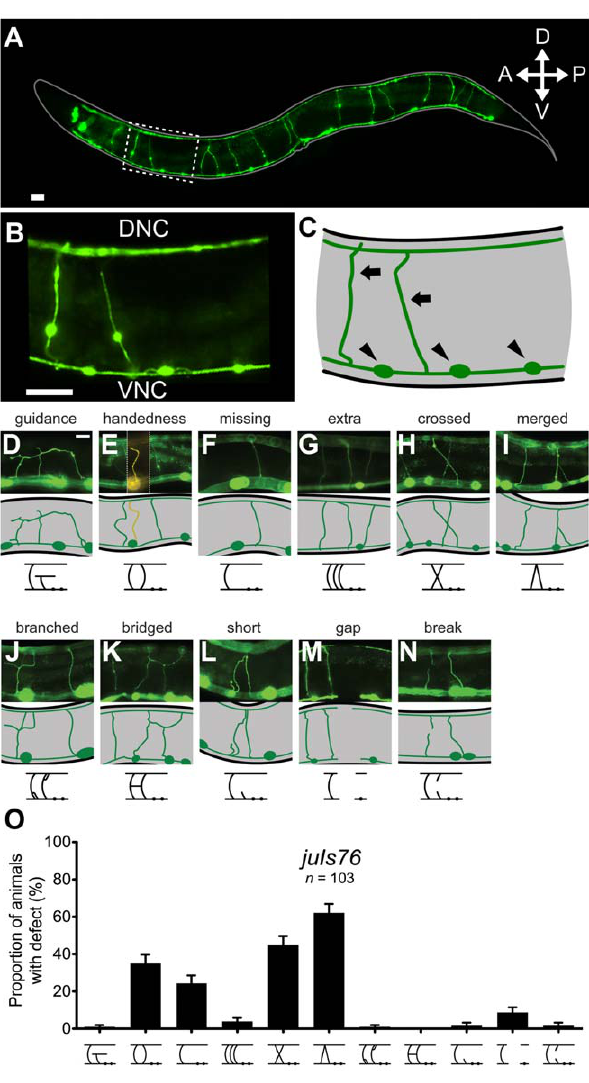
Figure 3. Morphology of wild-type and defective D-type motor neuron commissures. (A) Full body image of adult worm. Scale bar is 25 m m. (B) Expanded view of area within dashed box in panel A. Ventral nerve cord (VNC) is distinguished by presence of neuronal cell bodies. Dorsal nerve cord labeled DNC. Scale bar is 25 m m. (C) Representative image of panel B. Black arrows label neuronal commissures while black arrowheads identify neuronal cell bodies. Respective phenotypes characterized by: (D) commissure never reaching dorsal nerve cord; (E) commissure running along the opposite side of the animal’s body (left, colored yellow); (F) absent commissure; (G) additional commissure present; (H) two commissures crossing over each other; (I) two commissures entering the dorsal nerve cord or leaving the ventral nerve cord together, they may also partially fasciculate; (J) bifurcating commissure; (K) neighboring commissures joined by a process; (L) neurite with length less than half nematode width; (M) an absence of GFP expression along either dorsal or ventral nerve cords; (N) break in GFP expression in a commissure. Scale bar is 25 m m. Representative image of phenotype shown beneath each photo accompanied with illustrative phenotype symbol. (O) Proportion of animals in a population with at least one incidence of each independent defect. Error bars represent standard error of proportion.